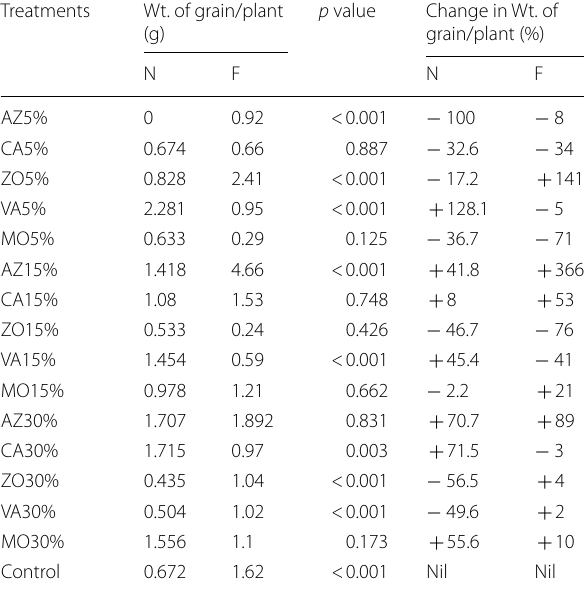
Table 7 Comparison of the yield performance of rice plants exposed to nanoparticles and sown in ferruginous and non- ferruginous soils Treatments